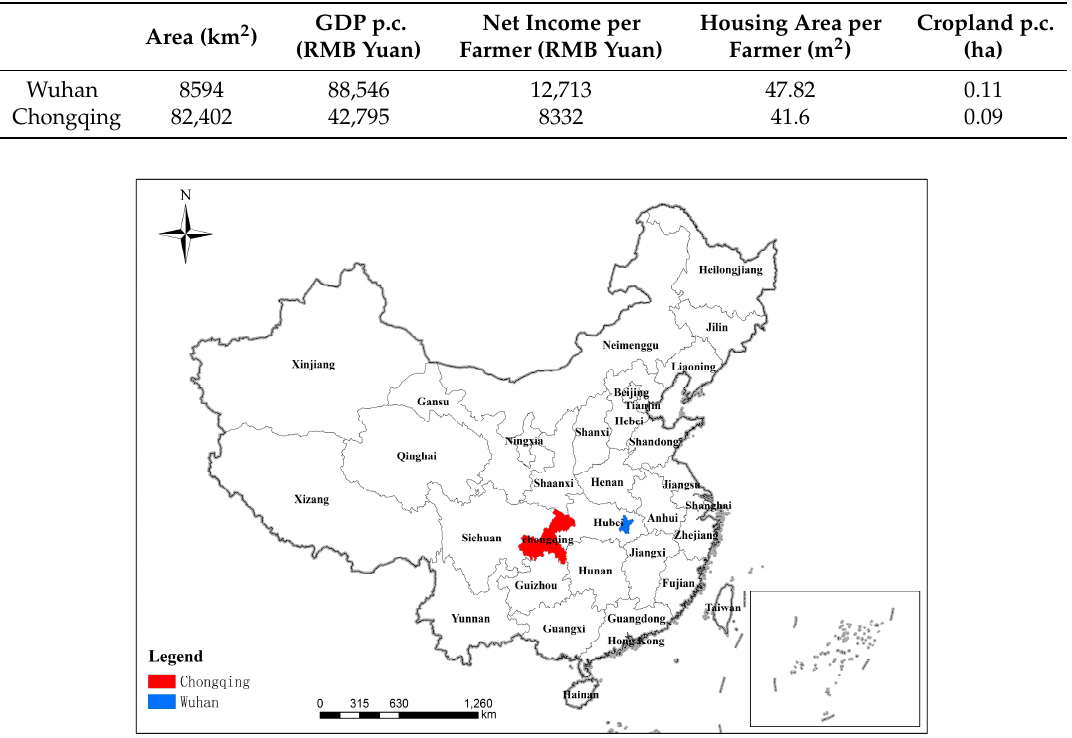
Figure 1. Location of the study areas.